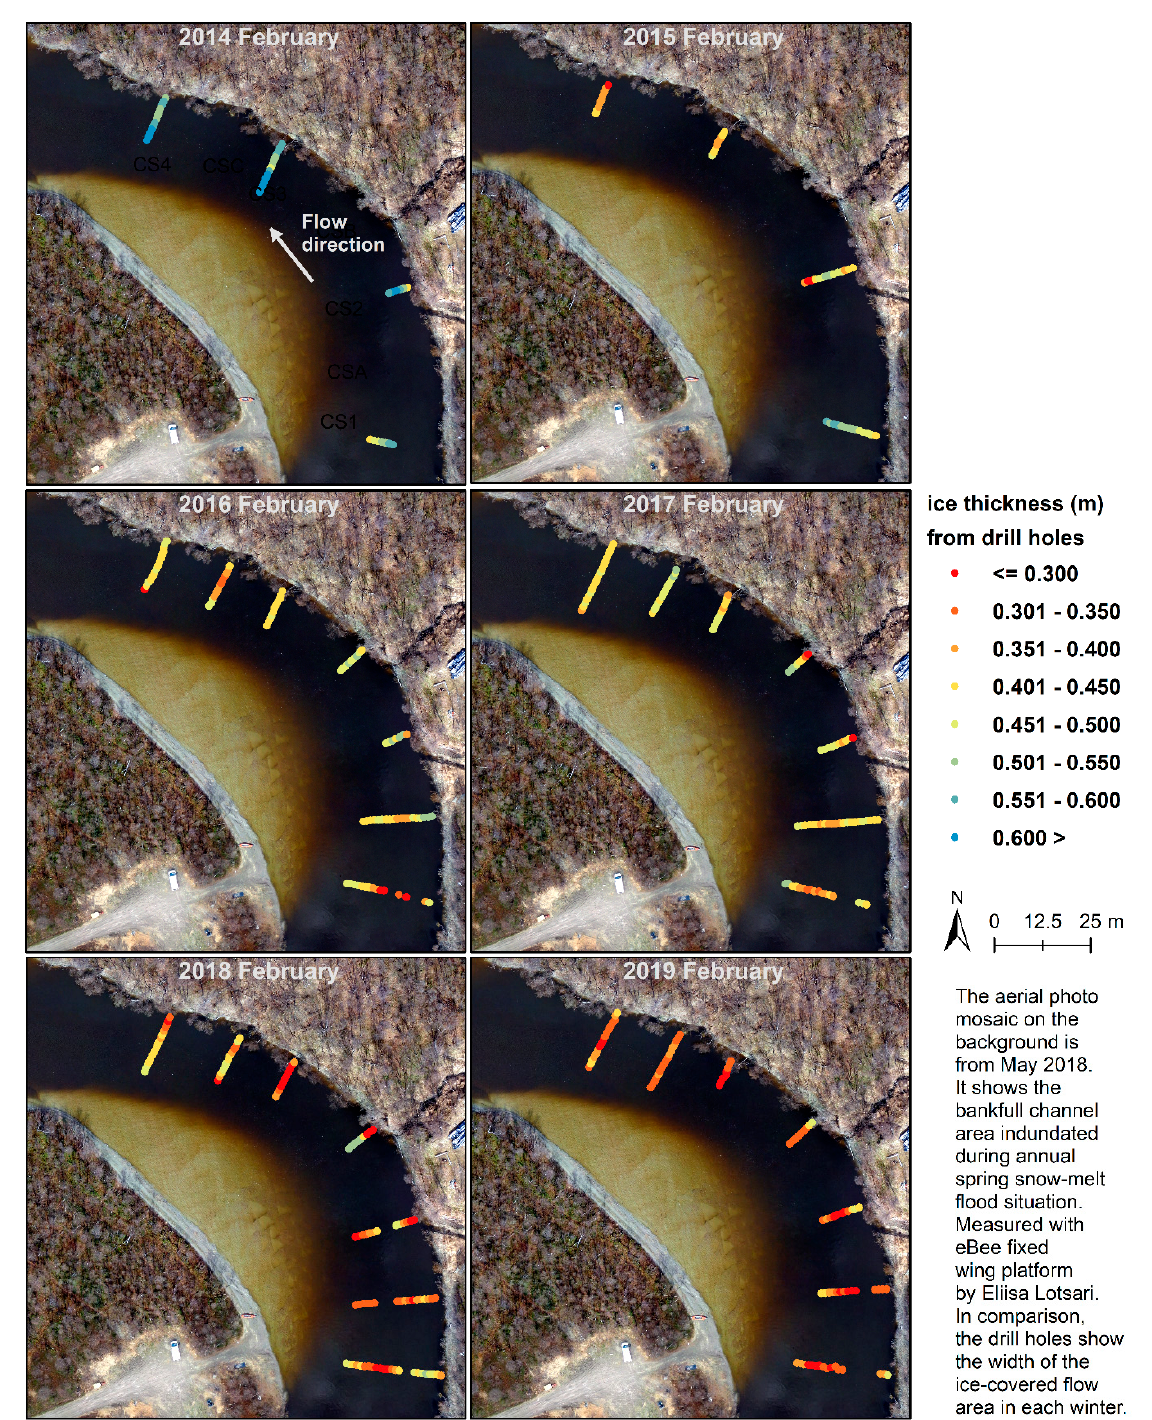
Figure 11. The ice cover thickness variation in the Pulmanki study site during the measurement periods. The mid-winter ice cover was the thinnest during February 2018 and February 2019.